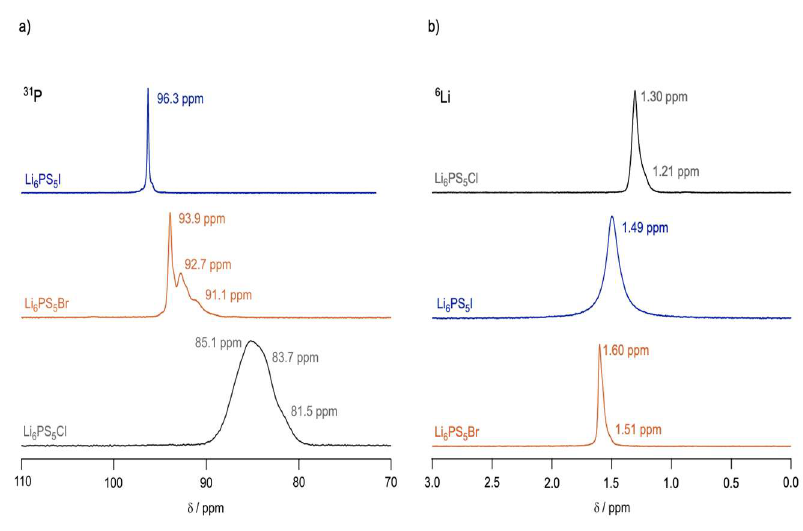
Figure 14. (Left) 31 P and (Right) 6 Li MAS spectra for all three argyrodites [46] .